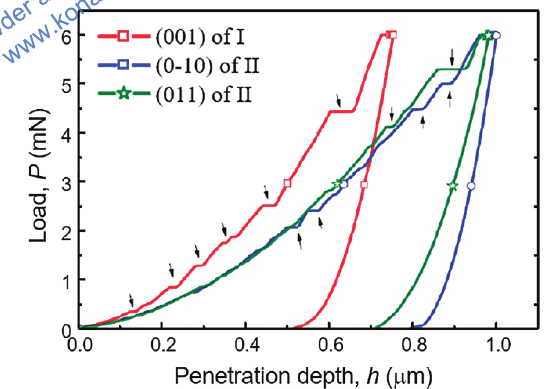
Fig. 7 Force-displacement curves for caffeine crystals (Form I). Reprinted with permission from Ref. Ghosh et al. 2009. Copyright: (2009) American Chemical